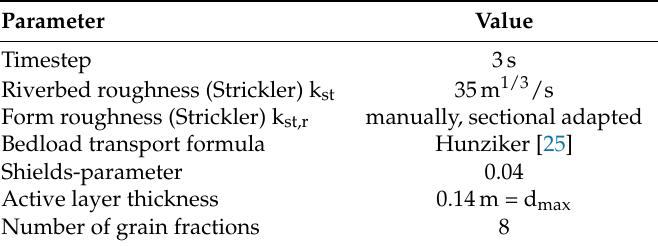
Table 1. Numerical model